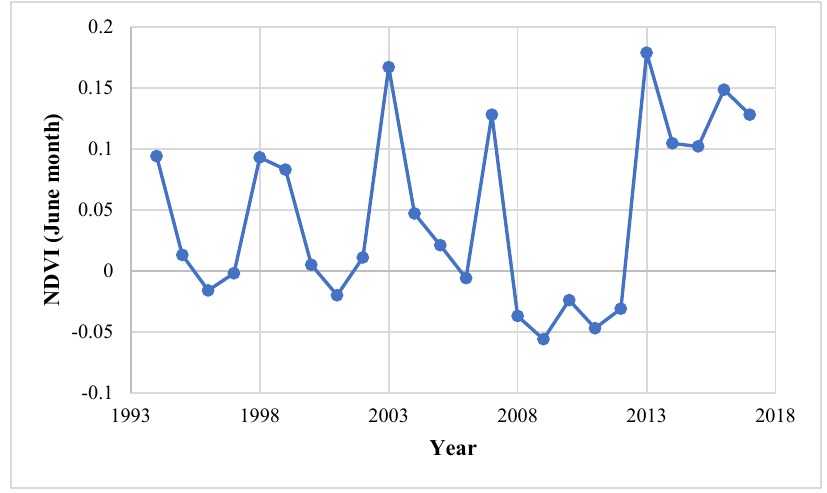
Figure 6. NDVI trend analysis (July month) over a period of 1994–2017.